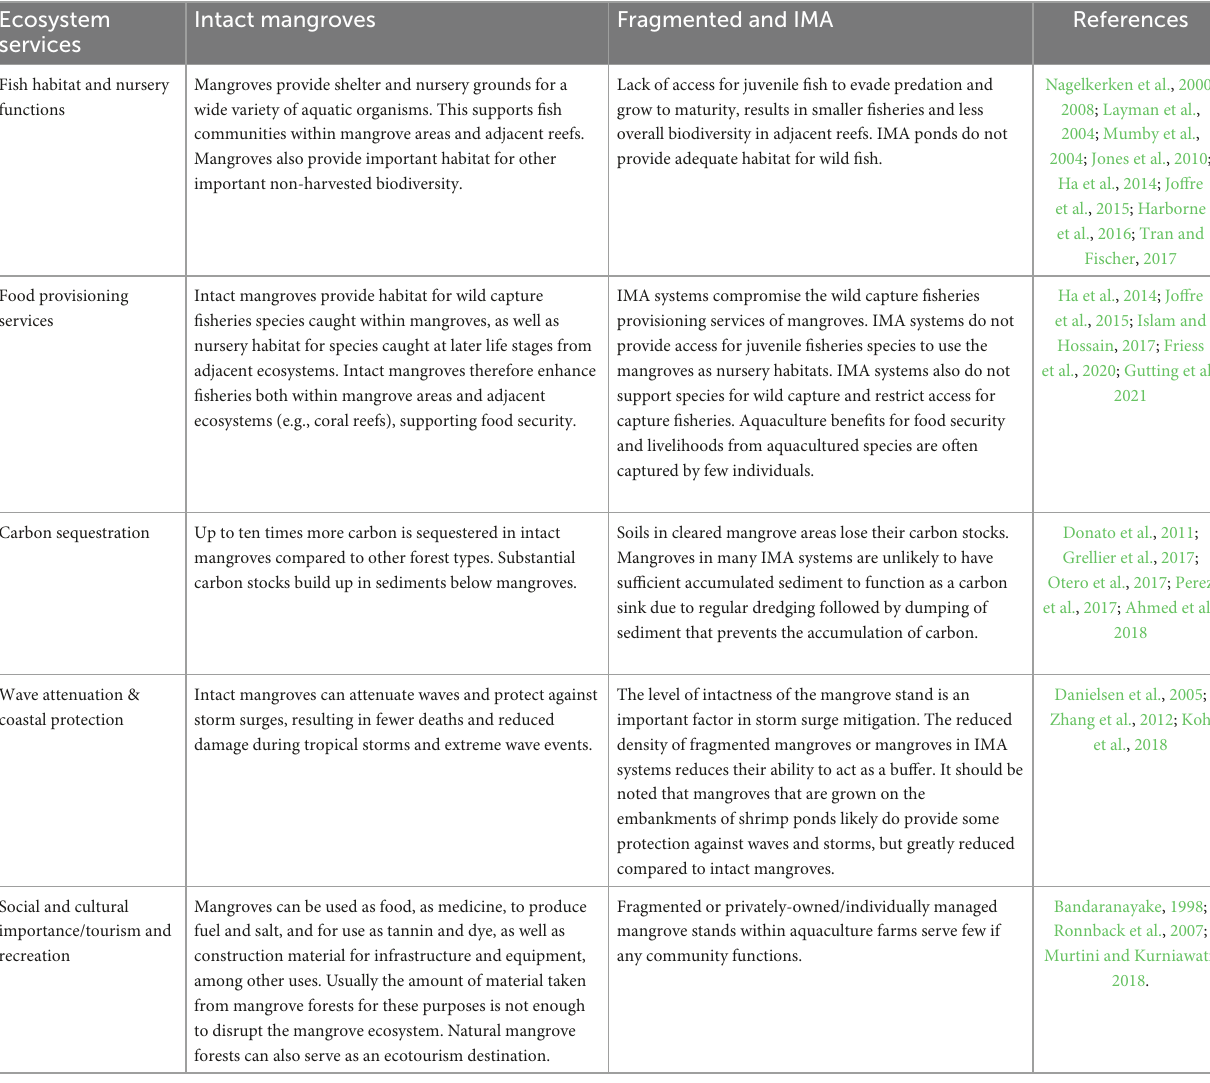
TABLE 1 Mangrove ecosystem functions and services, comparing intact mangrove forests and IMA shrimp